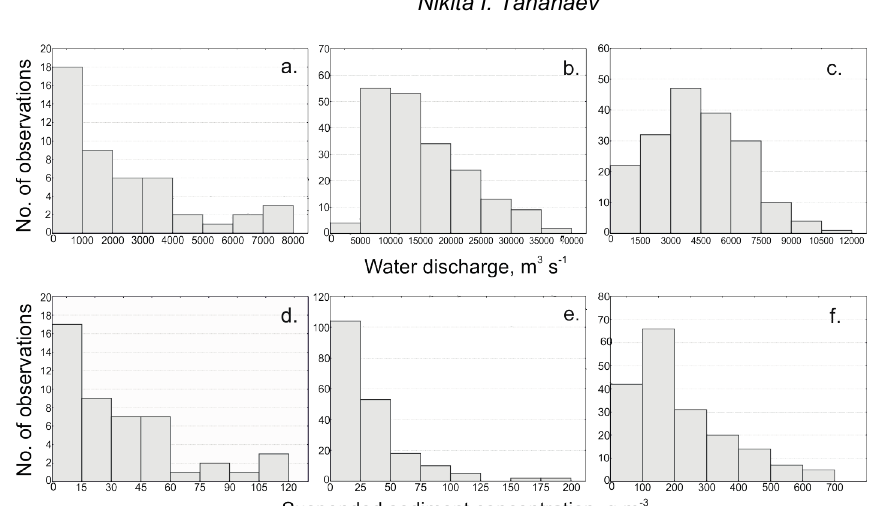
Fig. 2 Frequency distributions of water discharge and suspended sediment concentration for the Anabar (a, d), Lena (b, e) and Indigirka (c, f) rivers, respectively.